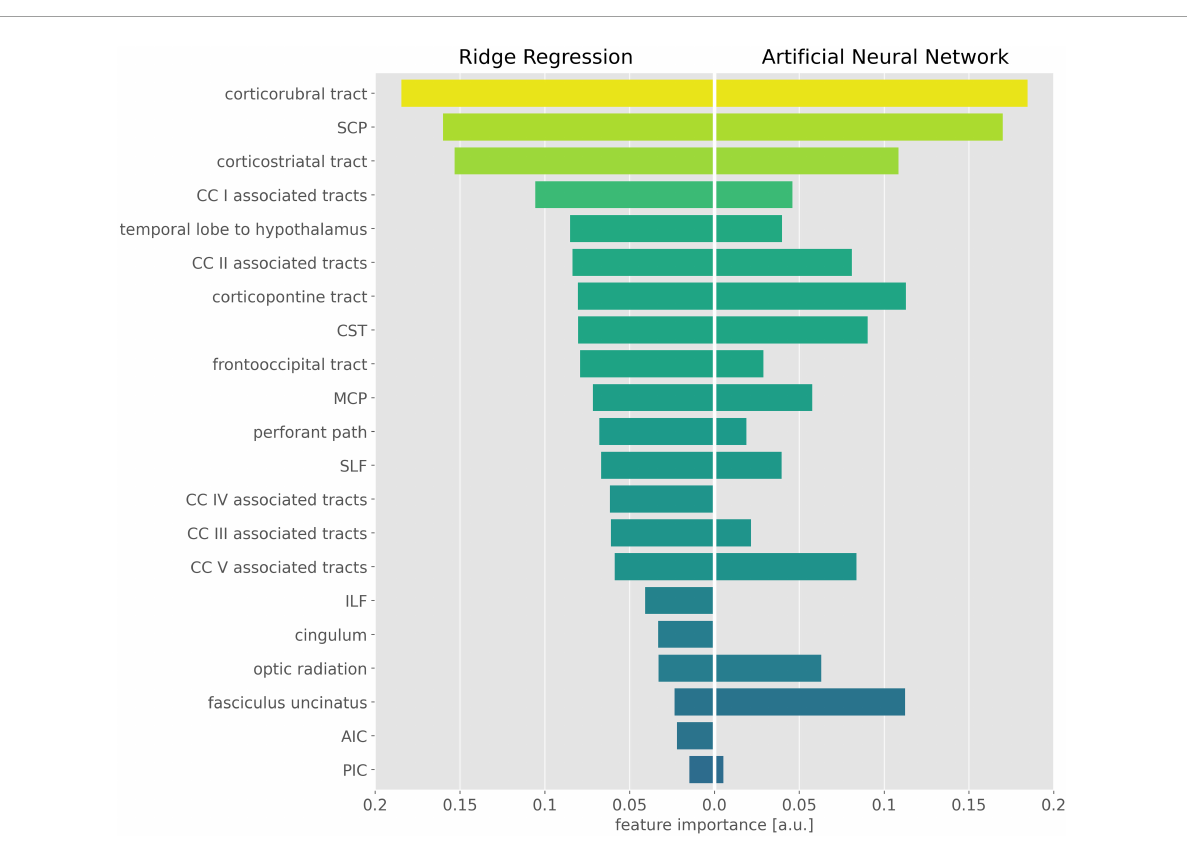
FIGURE2 Important features in the ridge regression and the artificial neural network (ANN). Feature importance is displayed as the absolute value of the ridge regression coefficients (Left) and the mean permutation importance (PI) values from the ANN (Right) . For better visualization, PI values were rescaled and negative PI values were set to 0. CST, corticospinal tract; SLF, superior longitudinal fasciculus; ILF, inferior longitudinal fasciculus; SCP, superior cerebellar peduncle; MCP, middle cerebellar peduncle; AIC, anterior limb of internal capsule; PIC, posterior limb of internal capsule; CC, corpus